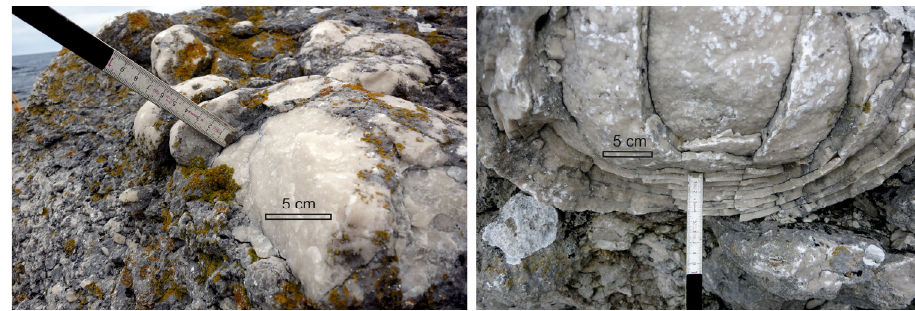
Figure 6. Example of erosion on rocks in Langhammars.